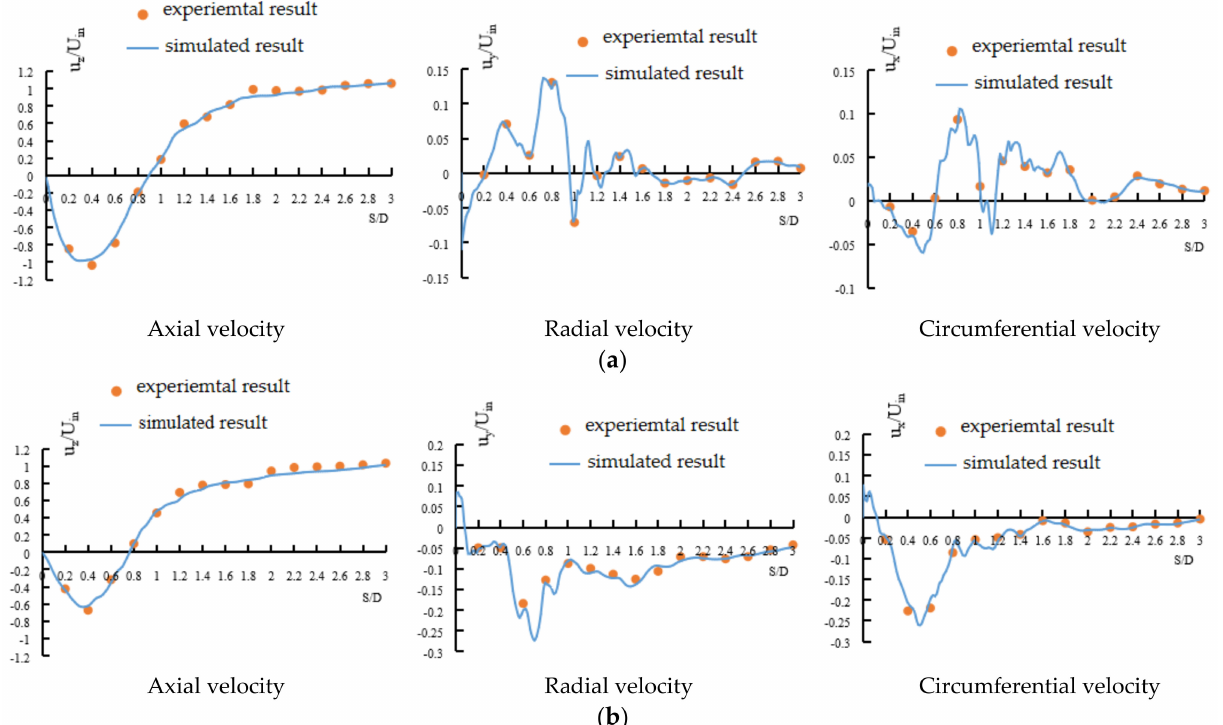
Figure 8. The experimental and simulated results of the three-dimensional velocities for rear flow: ( a ) K = 0.5; ( b ) K =